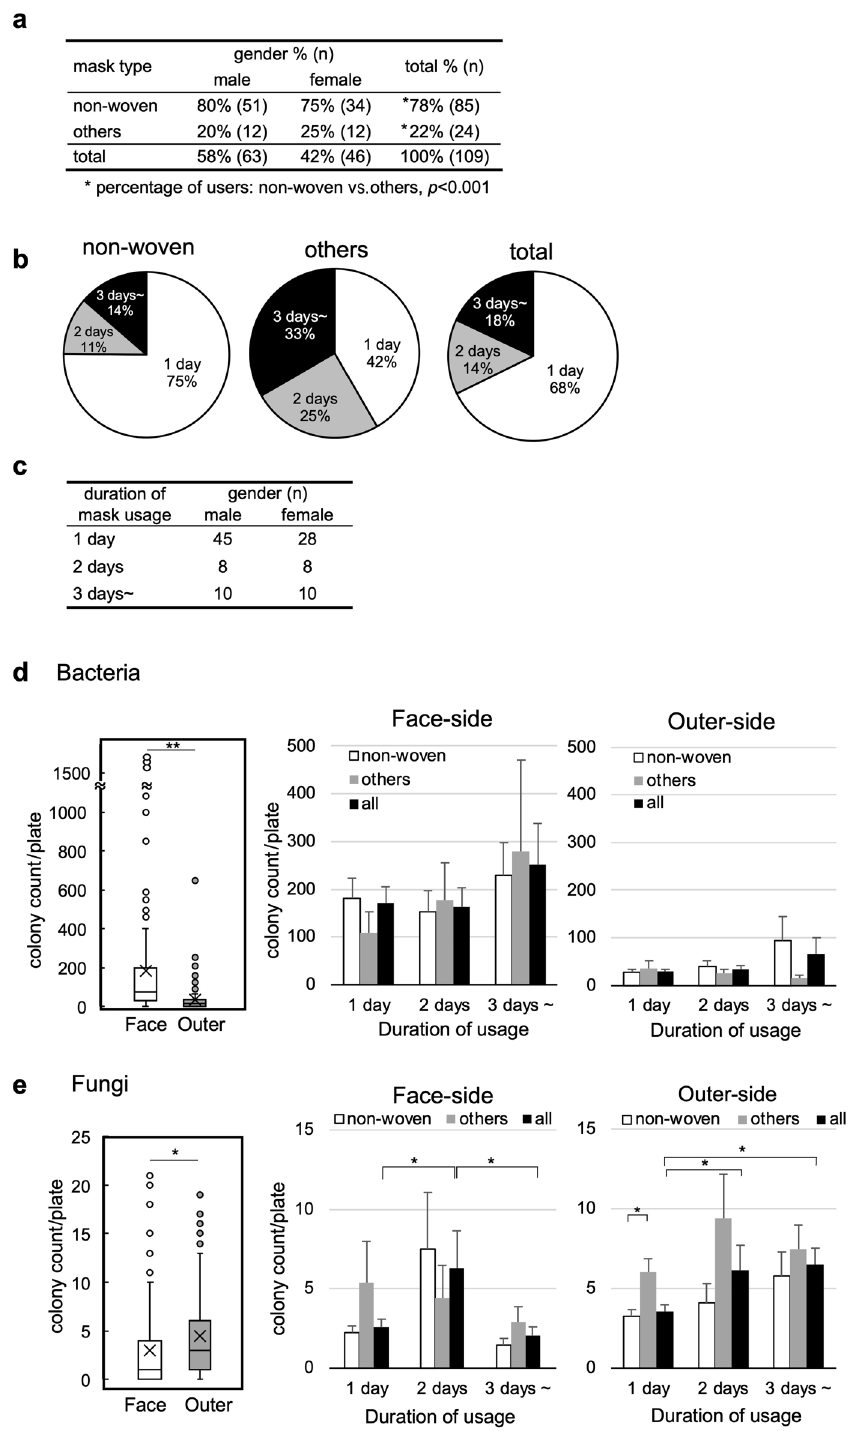
Figure 2. Survey results of the mask usage and microbe colony counts on the face-side and outer-side of the face masks. ( a ) Usage of non-woven masks and other mask types (others) among male and female participants (n = 109). Most “others” were polyurethane masks except a few gauze or cloth masks. ( b ) Duration of usage in non-woven, other mask types, and total (non-woven and others combined). The percentage of “others” wearing the same masks for two days or more (58%) was significantly higher than that of non-woven mask users (25%, P < 0.001). ( c ) Duration of mask usage in each gender (no significant difference). ( d , e ) Bacteria ( d ) and fungi ( e ) on the face-side and outer-side masks were cultured separately after pressing each mask surface onto agar plates. Microbial colony counts/plate (left panels); in boxplots, the cross symbols, bars, and dots indicate the mean, median, and outliers, respectively. Microbial colony counts on the face-side (middle panels) and outer- side (right panels) were compared based on the mask types and duration of mask usage. Mean + standard error of the mean (SEM). The paired t -test and Student’s t -test were used for statistical analyses. * P < 0.05; ** P <